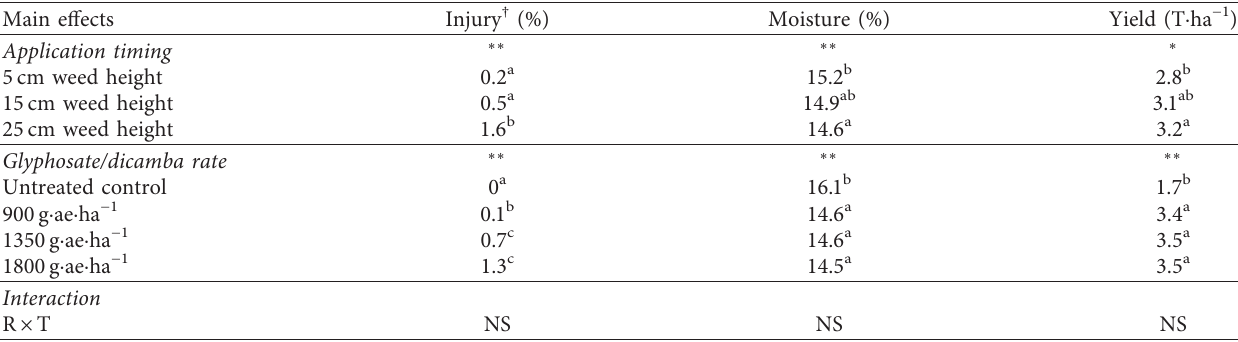
Table 2: Significance of main effects and interaction for percent visible soybean injury 1 WAA, soybean moisture content at harvest, and soybean yield treated with glyphosate/dicamba at various POSTapplication rates and timings at five Ridgetown, ON, sites (2016–2018) and two Exeter, ON, sites (2017-2018).